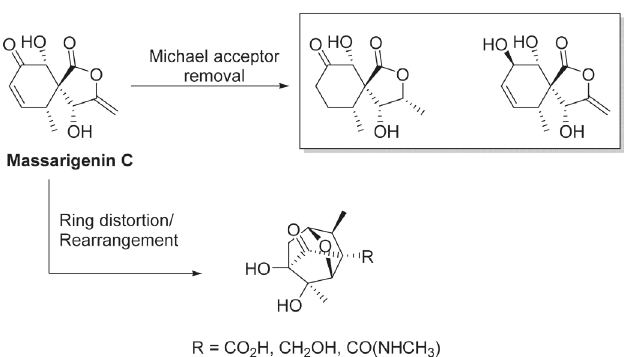
FIGURE 6 - Fragment-sized natural product derivatization toward drug-like compounds.